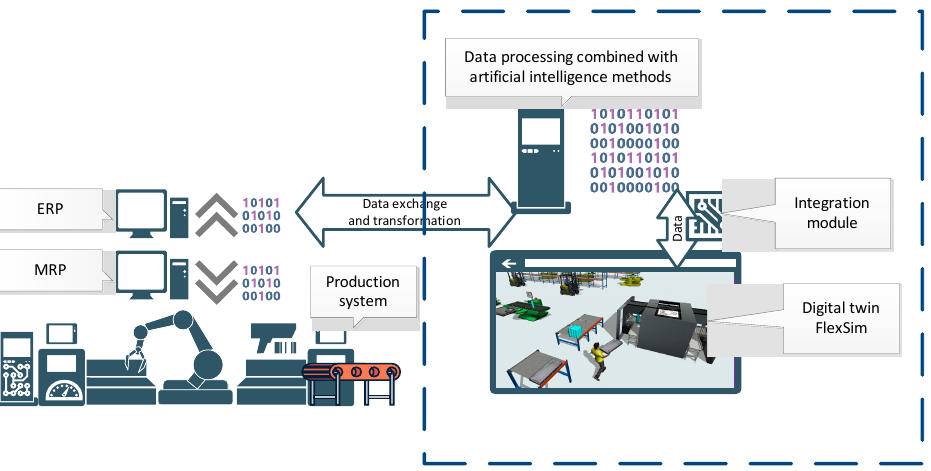
Figure 2. Simulation model integrated with analytical and optimization modules.